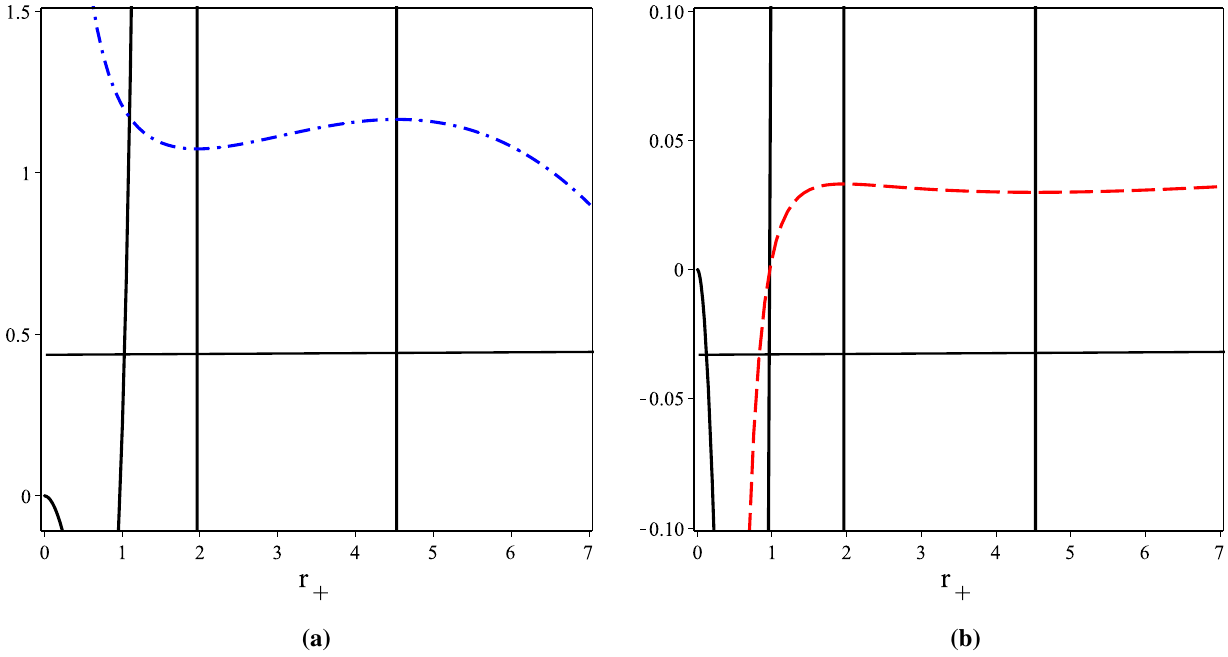
Fig. 5 The behavior of C P (solid line), T (dashed line) and G (dotted dashed line) in terms of r + for P = 0 . 0015 , Q =